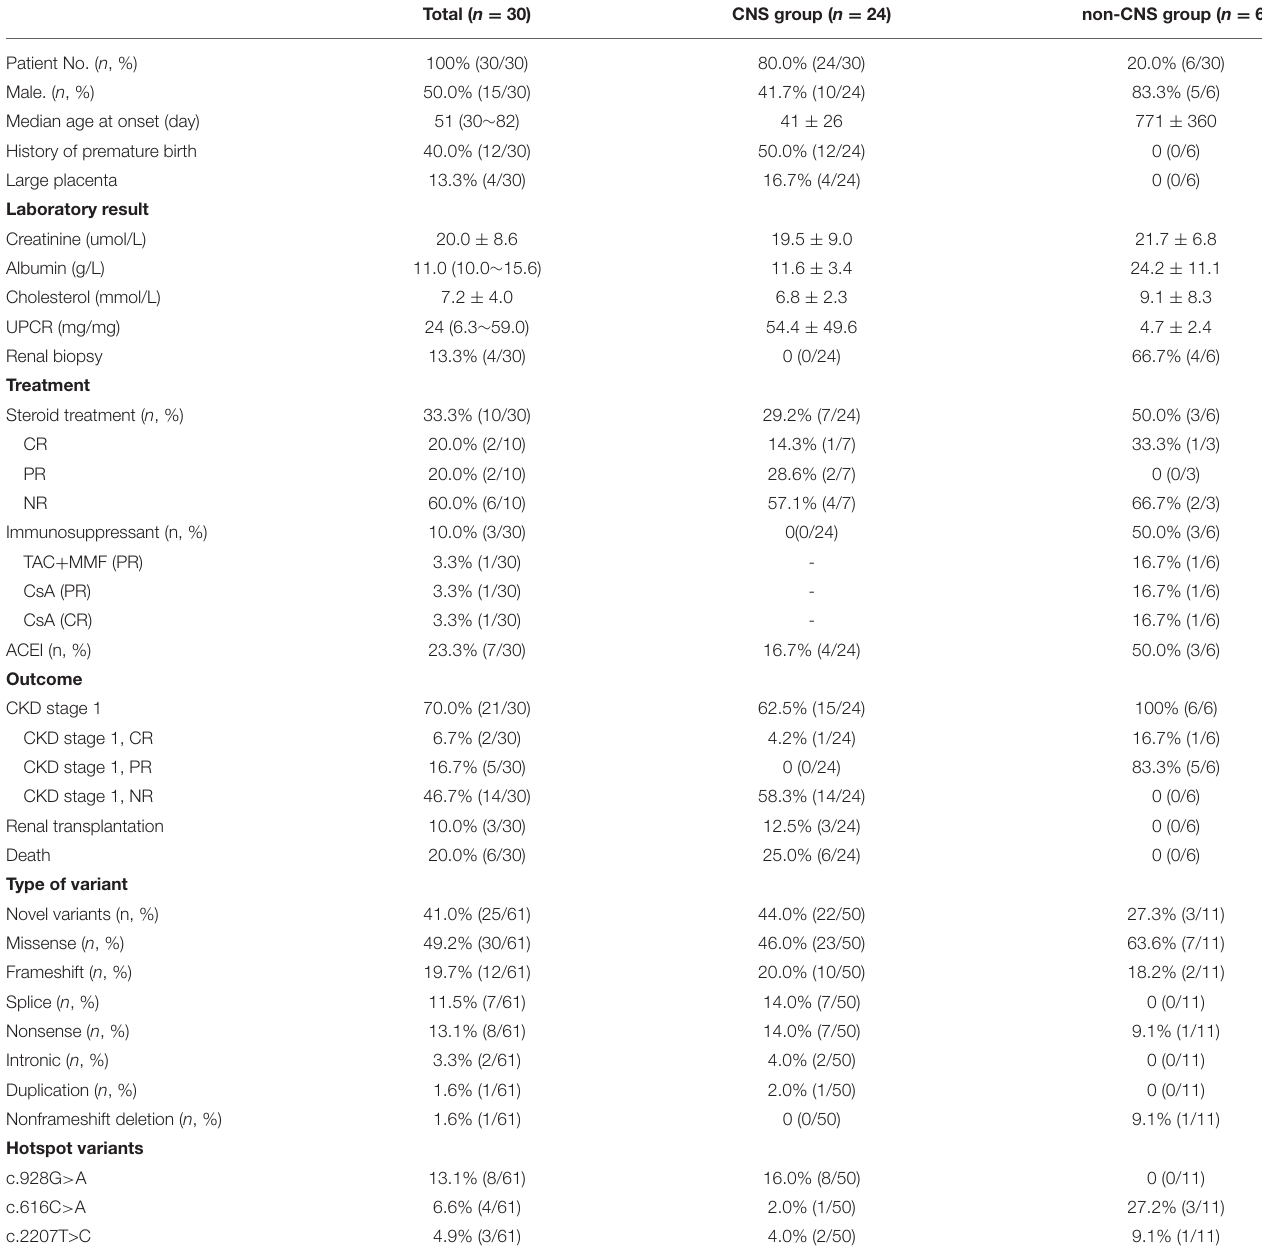
TABLE 2 | The comparison between CNS group and non-CNS group in